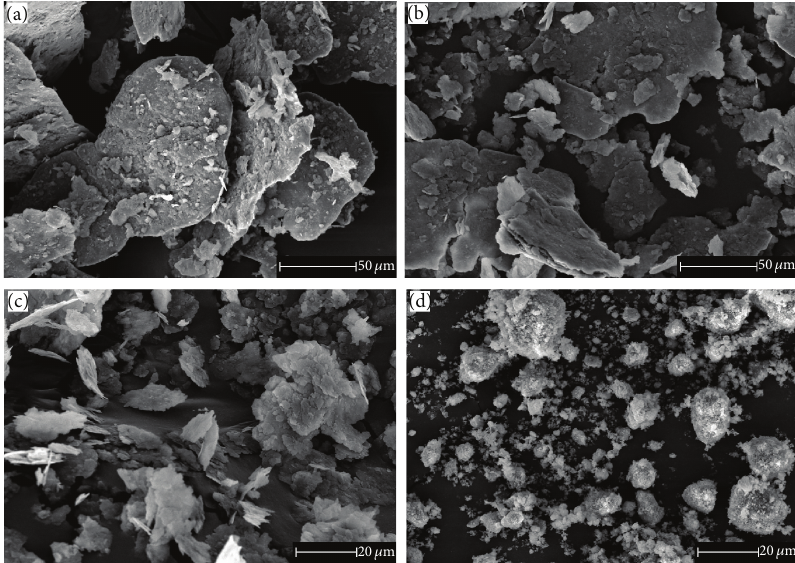
Figure 2: Morphological evolution of the milled powder in ammonia flow at 300 rpm for (a) 1h, (b) 2h, (c) 3 h, and (d) 5h. Note the different magnification